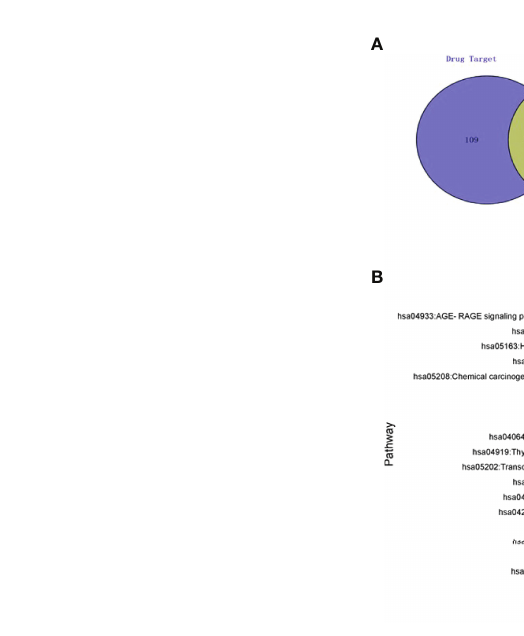
FIGURE 1 | Network pharmacological analyses. (A) Venn diagram of targets of TSWN formula and targets of diabetic nephropathy. (B) Pathway enrichment analysis of differential genes by TSWN formula treatment on diabetic nephropathy. The vertical axis represents the names of the 20 selected pathways, the color of the dot represents the -log10(P) value, the size represents the number of genes, and the horizontal axis is the enrichment of